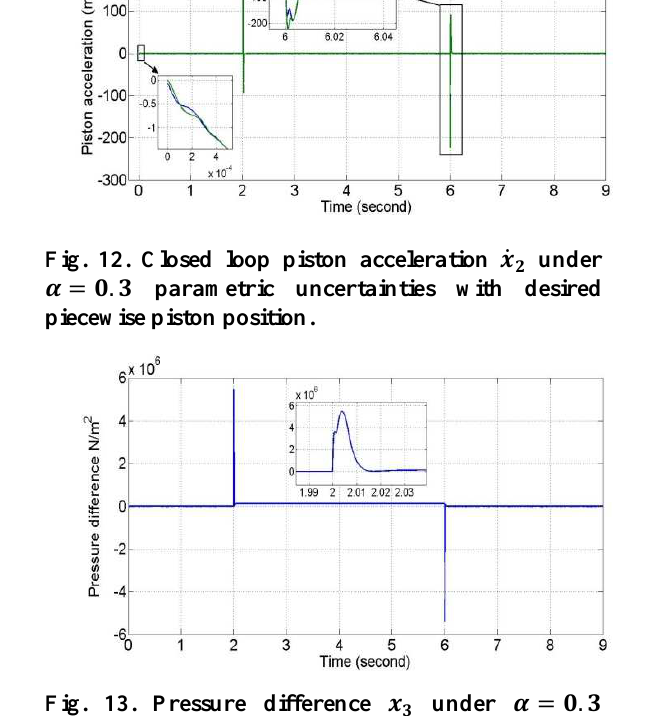
Fig. 13. Pressure difference parametric uncertainties with desired piecewise piston position.